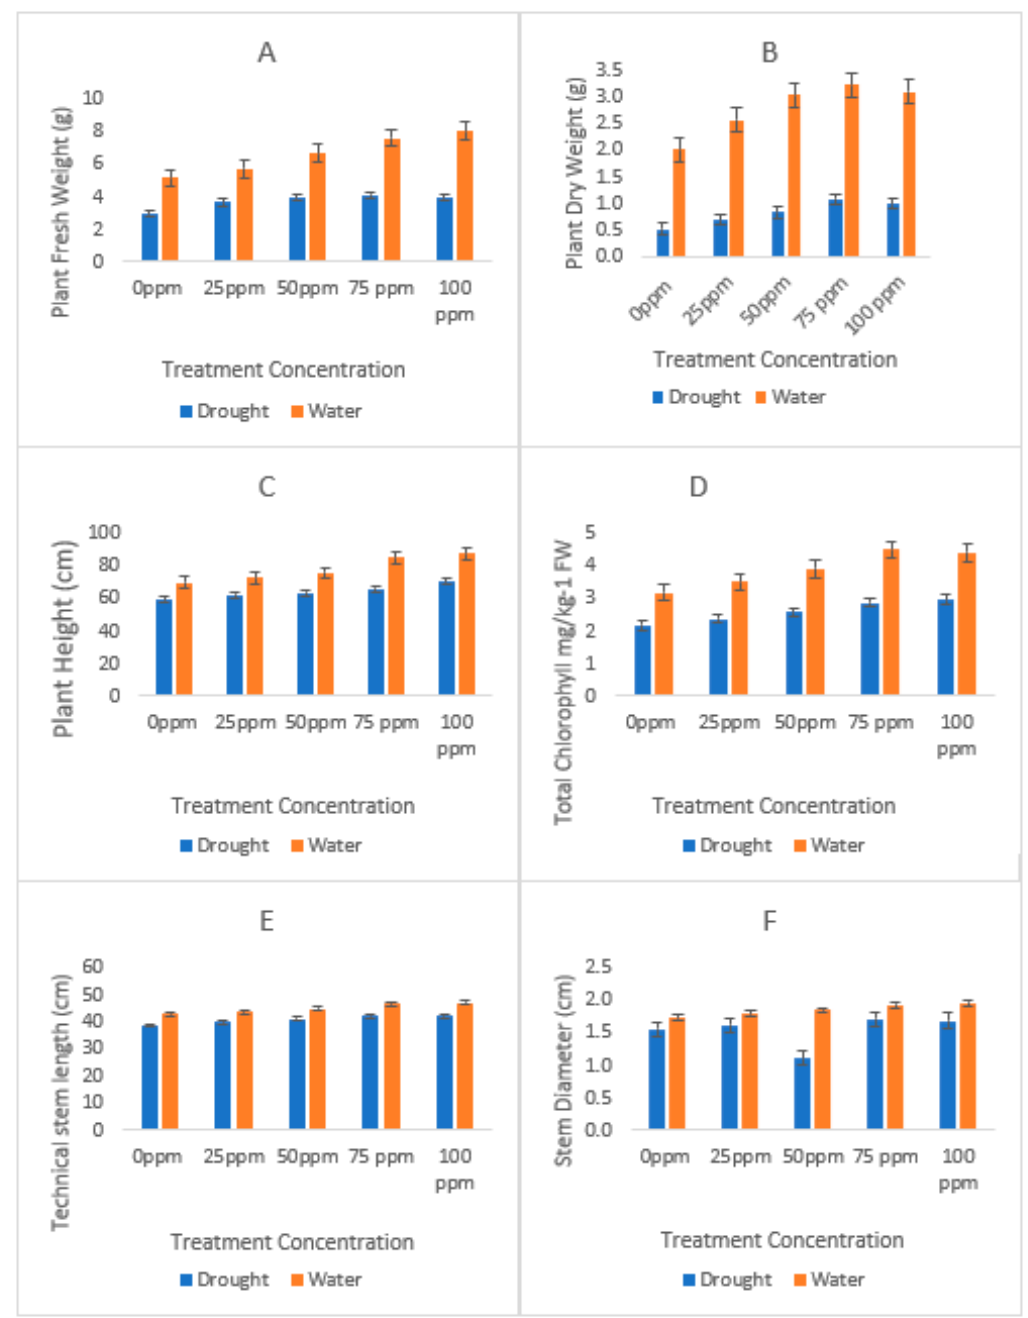
Figure 2. Growth and total chlorophyll values of flax plant samples; where ( A ) represents fresh weight (FW); ( B ) shows dry weight (DW); ( C ) shows plant height (PG); ( D ) depicts total chlorophyll contents (TCC); ( E ) shows technical stem length (TSL); and ( F ) shows stem diameter (SD). Impacts of different conc. (doses) of IONPs in different water scarcity and well-irrigated trials (measured in mean ± SE; replica ( n ) =